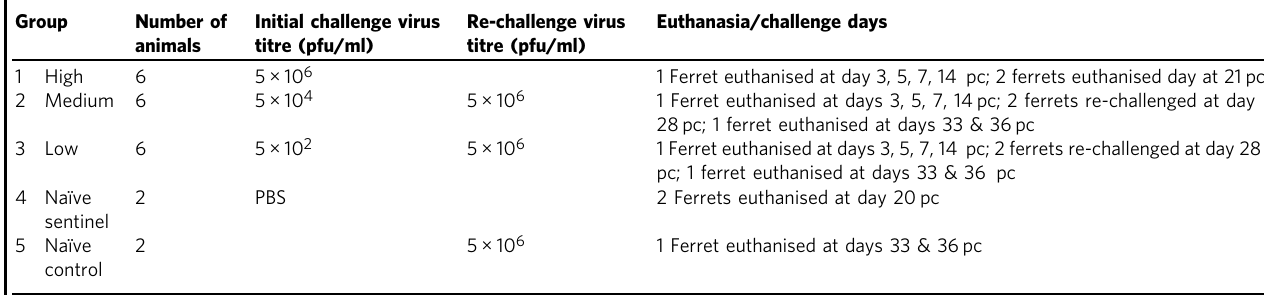
Table 1 Experimental animal